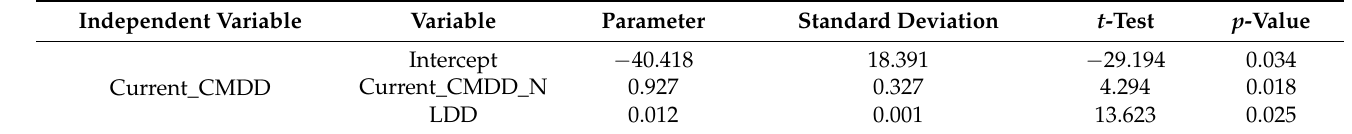
Table 5. Statistics of the CCLM.